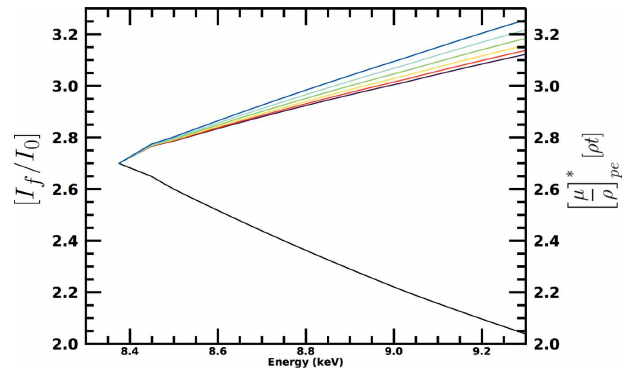
Figure 5 A simple simulation of a nickel metal X-ray absorption spectrum (shown in black, axis on right) transformed by self-absorption and attenuation (colours matching pixels, scaled axis on left), using the same distances and geometry as in the experimental data considered here. Oscillatory XAFS is not simulated in this